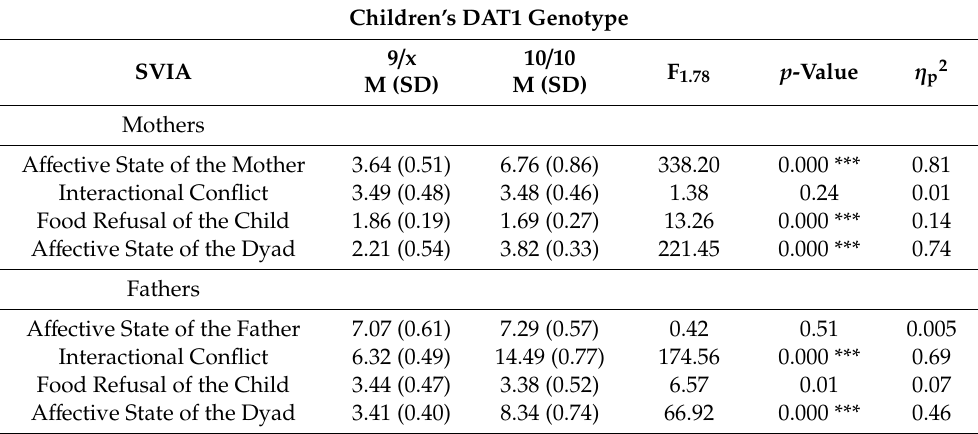
Table 5. Univariate results of the di ff erences between the two groups on mother–child feeding interactions (controlling for maternal psychopathological risk) and father–child feeding interactions (controlling for children’s internalizing